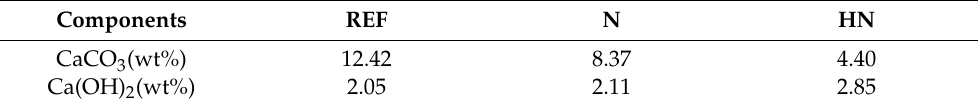
Table 6. Content of CaCO 3 and Ca(OH) 2 in different samples after carbonation. Components